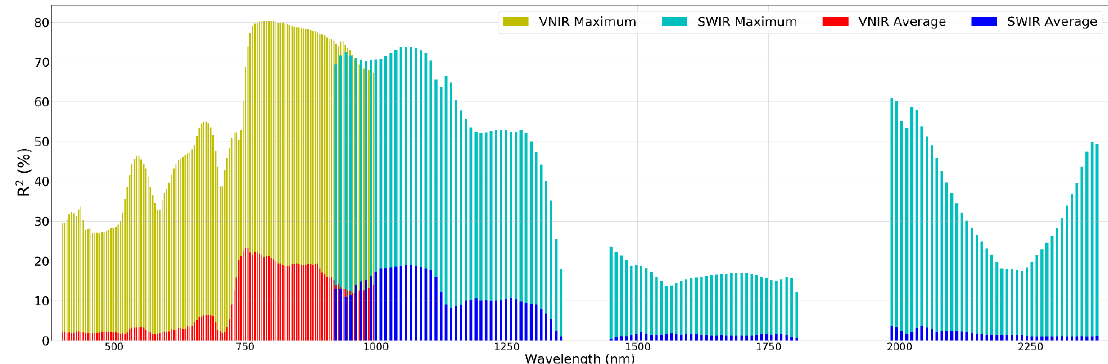
Figure 17. Average and maximum R 2 values of the linear models developed for all the dates and all the experiments for each band from hyperspectral VNIR and short-wave infrared (SWIR) data.